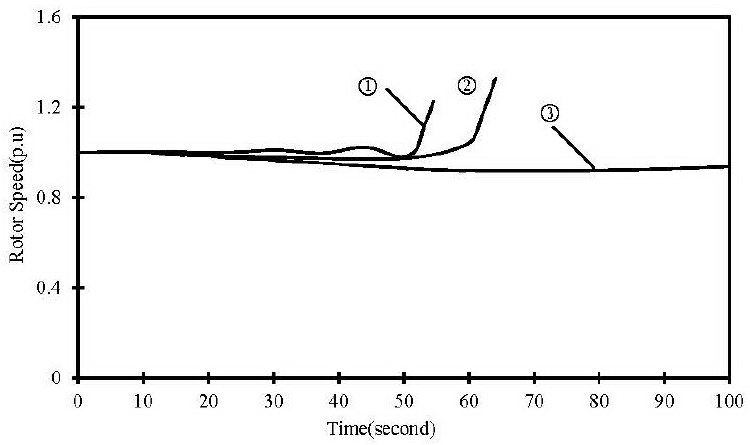
Figure 13. Generator Angle of key bus Yinmin.